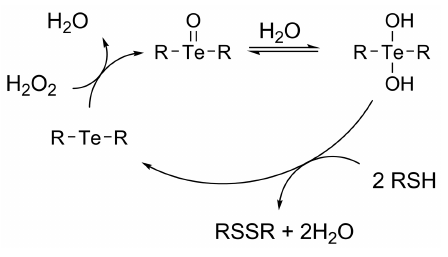
Fig. 5 – Proposed mechanism of the GPx-like activity of diorganotel- lurides (adapted from Engman et al.